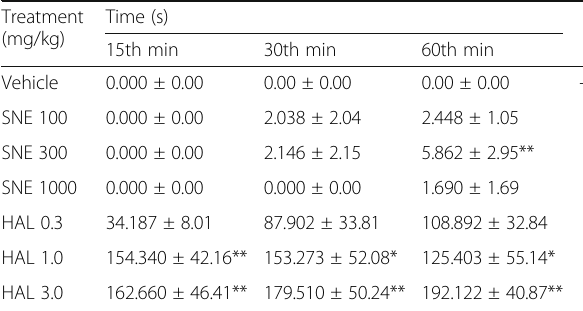
Table 2 Effect of extracts SNE, haloperidol (HAL) and vehicle on the duration of catalepsy Treatment